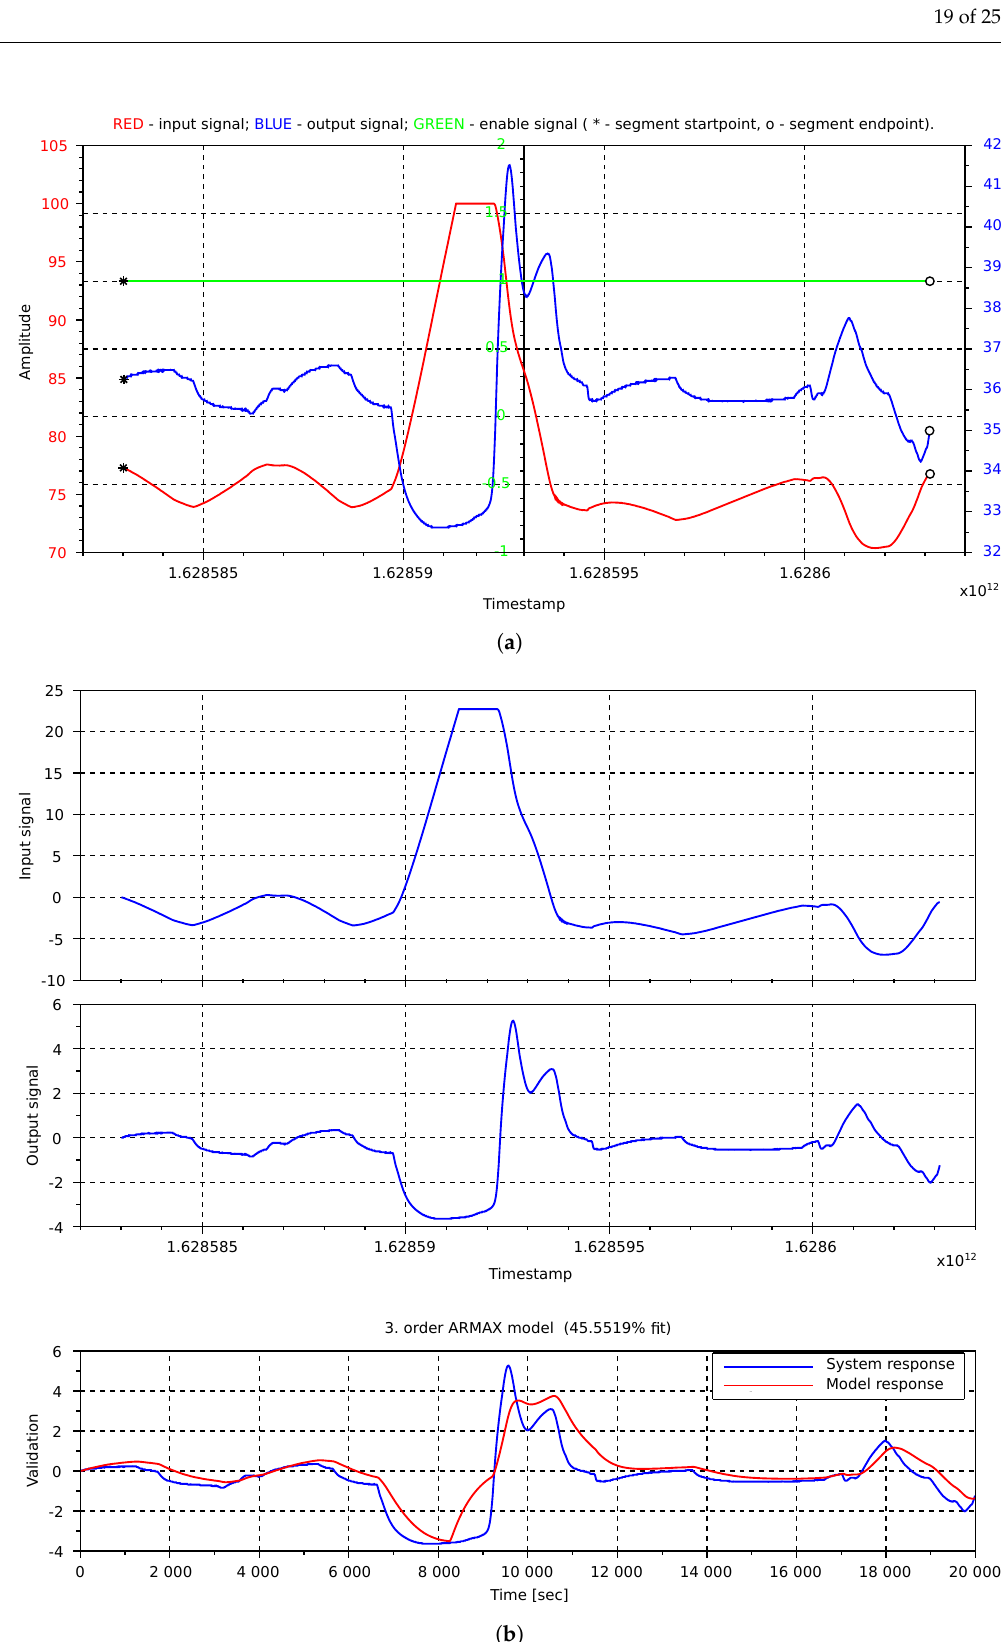
Figure 8. Graphical output from identification of the cooling process in the real building. ( a ) Input, output and enable/disable signals, and their segmentation. ( b ) Input and output data used for identification and model